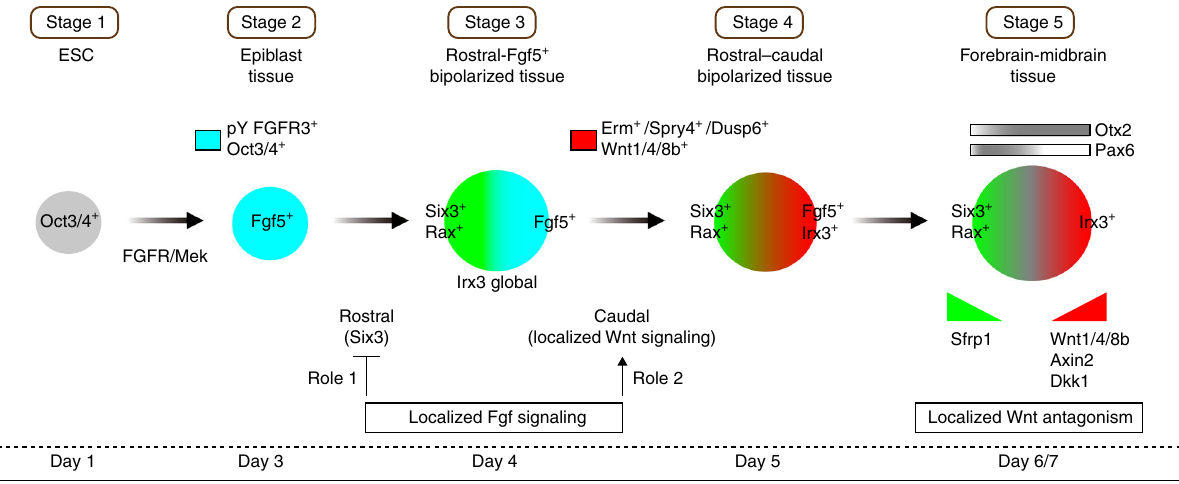
Fig. 7 Overview of Fgf and Wnt signaling in rostral-caudal patterning of ESC-derived neuroectoderm. The processes of self-patterning in 3-D ESC culture. ESC differentiates into Fgf5 + epiblast. Six3 + rostral polarization is spontaneously generated. Localized Fgf signaling performs dual roles; in the early stage, suppression of Six3 + rostral cells in the presumptive caudal region; in the later stage, promotion of Wnt signaling. Localized Wnt signaling generates a Irx3 + caudal identity. Wnt antagonist and agonist gradients maintain a rostral-caudal neural pattern, which would be similar to the region from forebrain